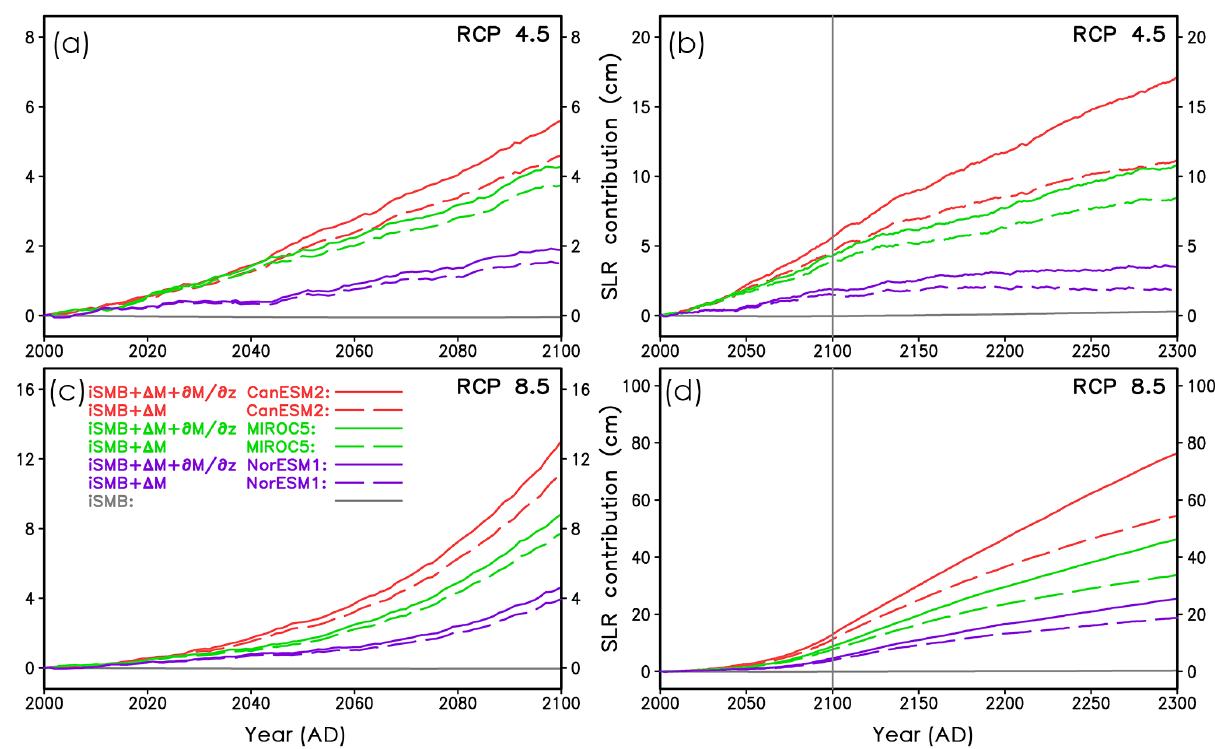
Figure 10. Contribution of the Greenland ice sheet to future sea level rise under MAR forcing for different scenarios. Sea level rise is referenced to the year 2000. Beyond 2100, the forcings of the projections are from prolongations of the original MAR data (see main text for details). This is indicated by the vertical grey line at the year 2100 in panels (b) and (d) . RCP 4.5 projections: (a) years 2000–2100 and (b) years 2000–2300. RCP 8.5 projections: (c) years 2000–2100 and (d) years 2000–2300. The different CMIP5 general circulation models utilized by MAR are indicated by colours. Different line characteristics specify optimal simulations with (solid) and without (long dashed) elevation correction for the SMB. The grey curves in panels (a) to (d) indicate a control simulation with solely the implied SMB (iSMB) as forcing. All simulations are with hybrid ice dynamics and HYDRO basal